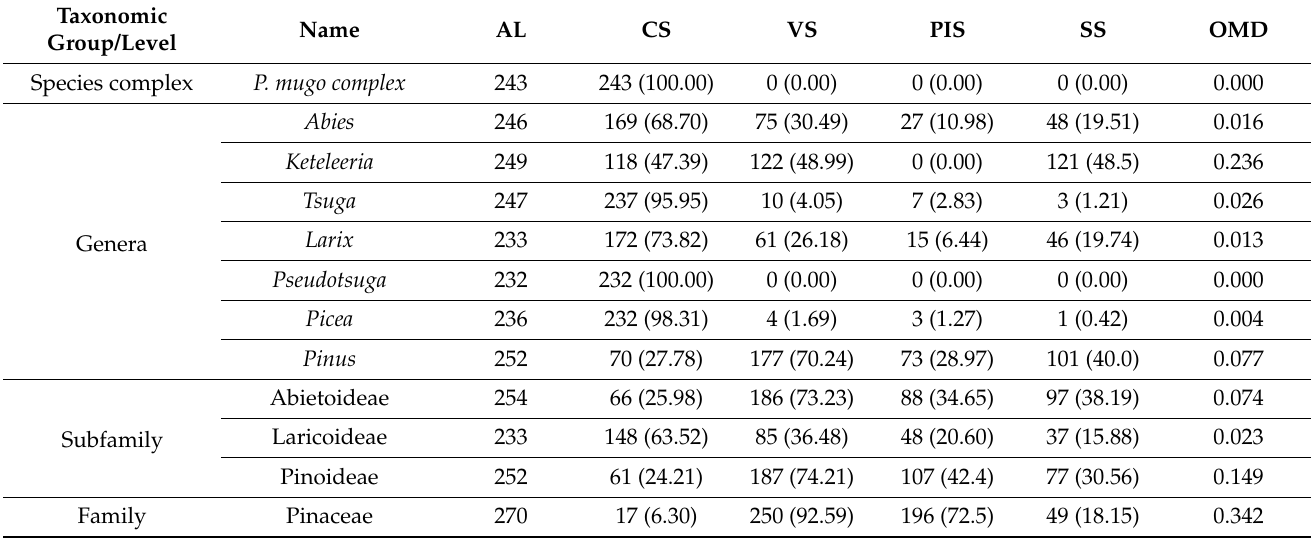
Table 1. Values of basic parameters characterizing genetic variation in ITS2 sequences in Pinaceae. AL—alignment length; CS—conserved sites; VS-variable sites; PIS—parsimony informative sites; SS—singleton sites; OMD—overall mean distance. Values in brackets are given as